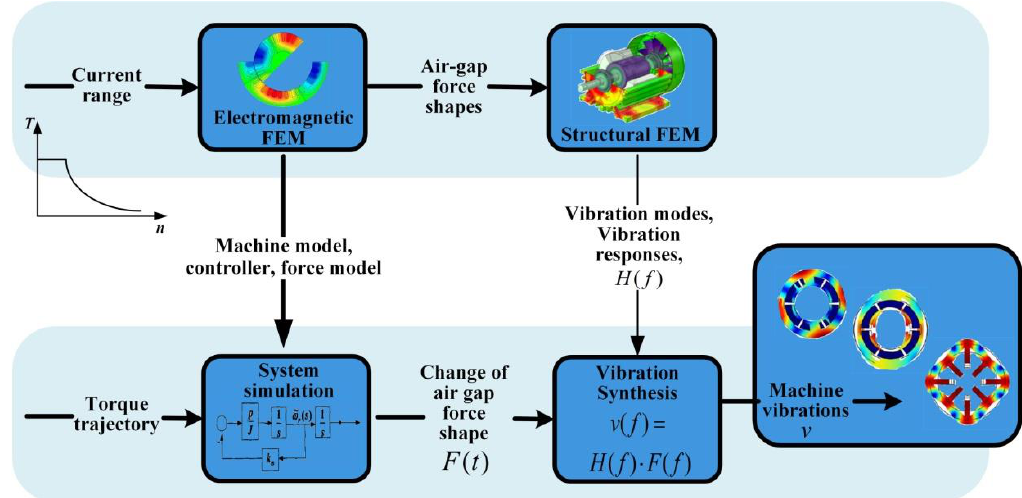
Figure 1. Electromagnetic - vibration analysis framework diagram.